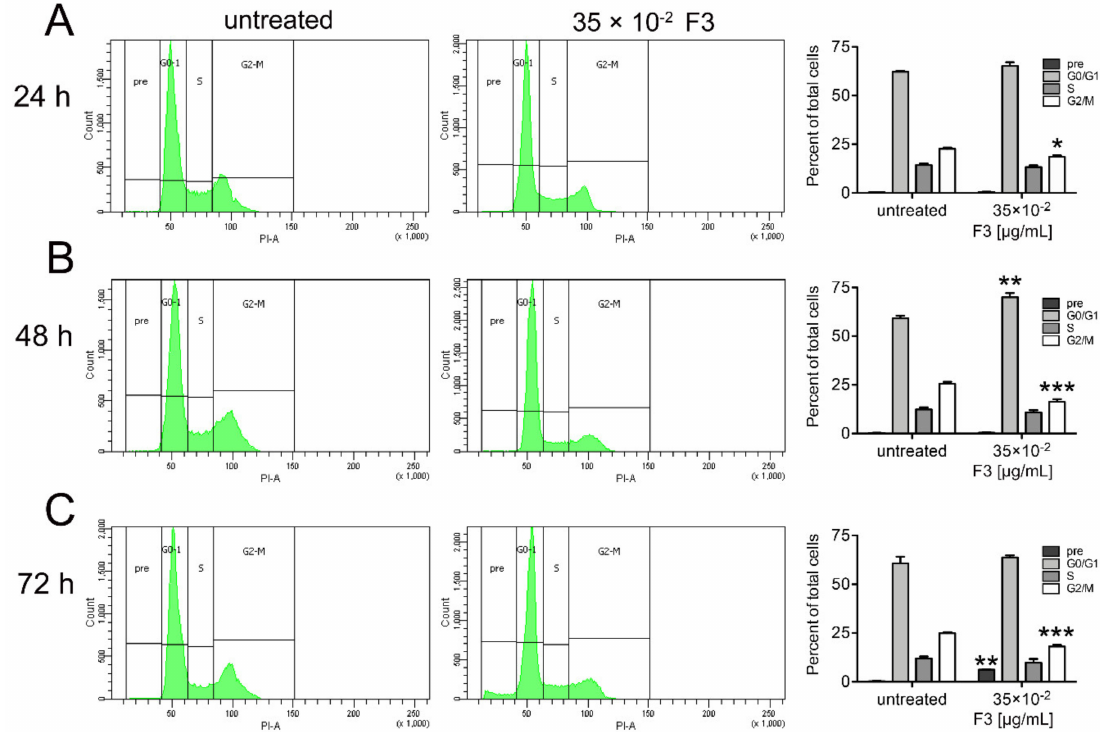
Figure 5. E ff ect of F3 on cell cycle arrest regulation in DU 145 cells. The cells were exposed to 35 × 10 − 2 µ g / mL F3 for 24- ( A ), 48- ( B ) and 72 ( C ) h and cell cycle distribution was analyzed by flow cytometry (FCM). The results are expressed as mean ± SD of three independent experiments * ( p < 0.05), ** ( p < 0.01), *** ( p <